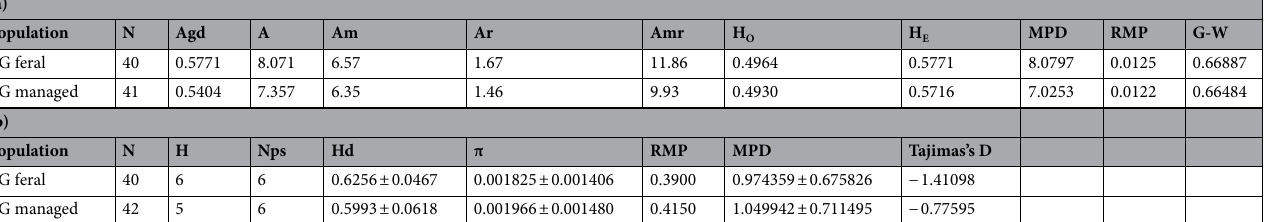
Table 1. Genetic diversity parameters: (a) microsatelites, (b) mtDNA tRNA leu -cox2 intergenic region. (a) N number of individuals, Agd average gene diversity over loci, A average number of alleles, Am number of alleles based on a minimal sample size of 40 diploid individuals, Ar number of private alleles based on a sample of 40 diploid individuals, Amr mean allelic range, H O observed heterozygosity, H E expected heterozygosity, MPD mean number of pairwise differences, RMP random match probability, G-W Garza Williamson index. (b) N number of individuals, H number of haplotypes, Nps number of polymorphic sites, Hd haplotype diversity, π nucleotide diversity, RMP random match probability, MPD mean number of pairwise